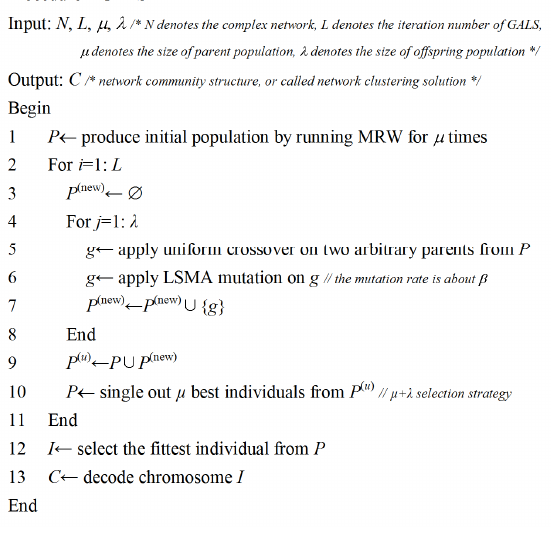
Fig. 5. GALS algorithm. Algorithm GALS starts by adopting a